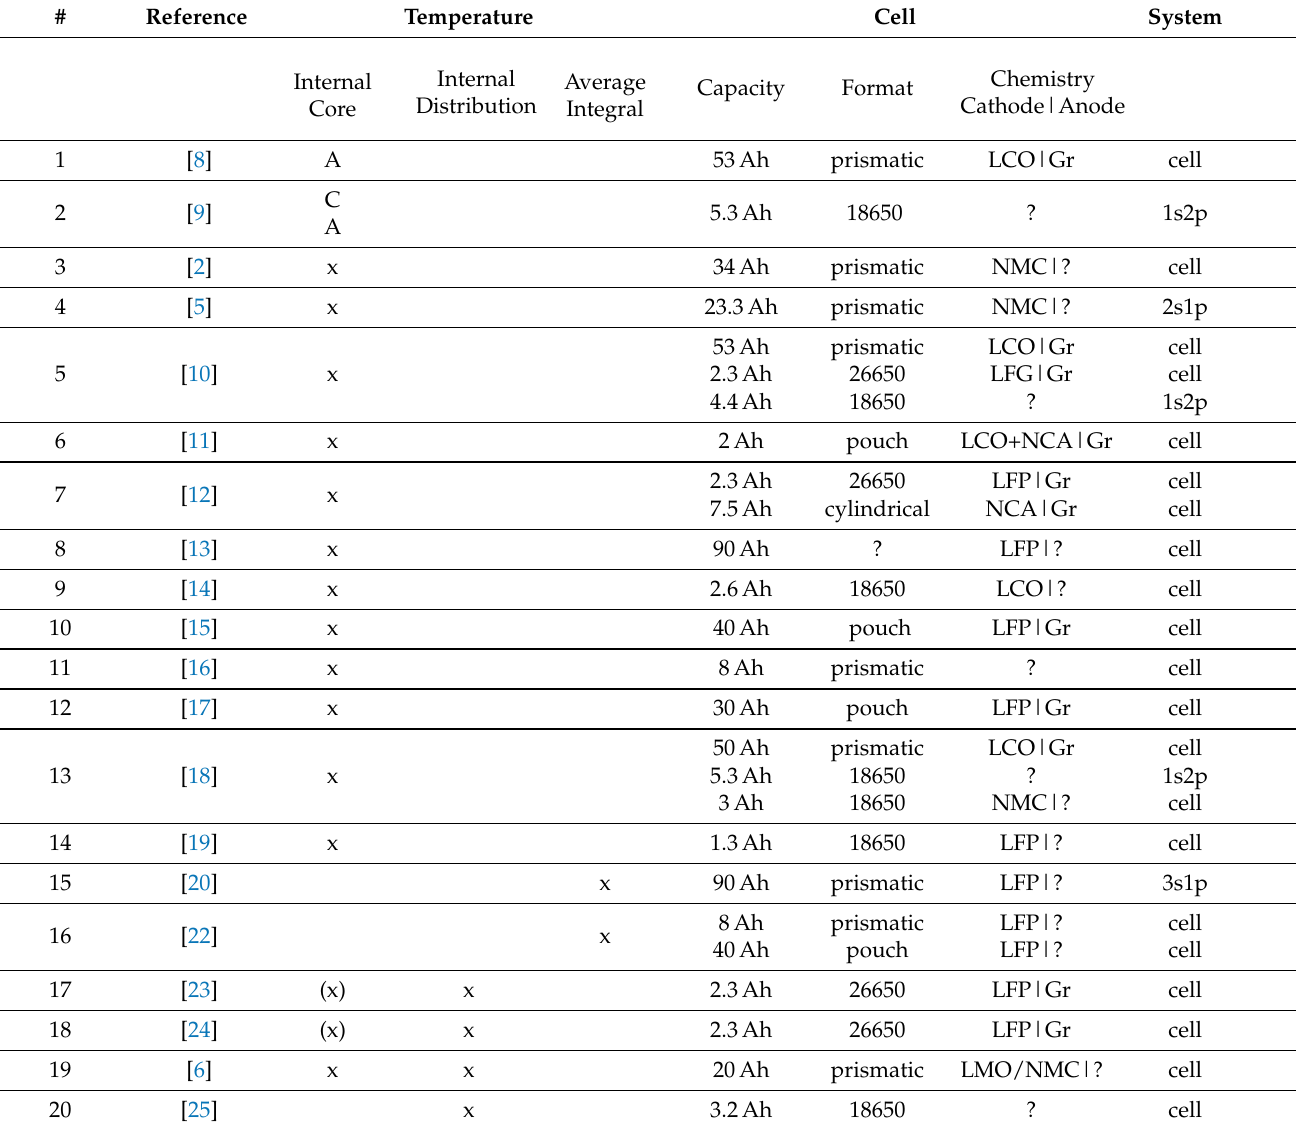
Table 1. Overview of impedance-based temperature estimation methods in the